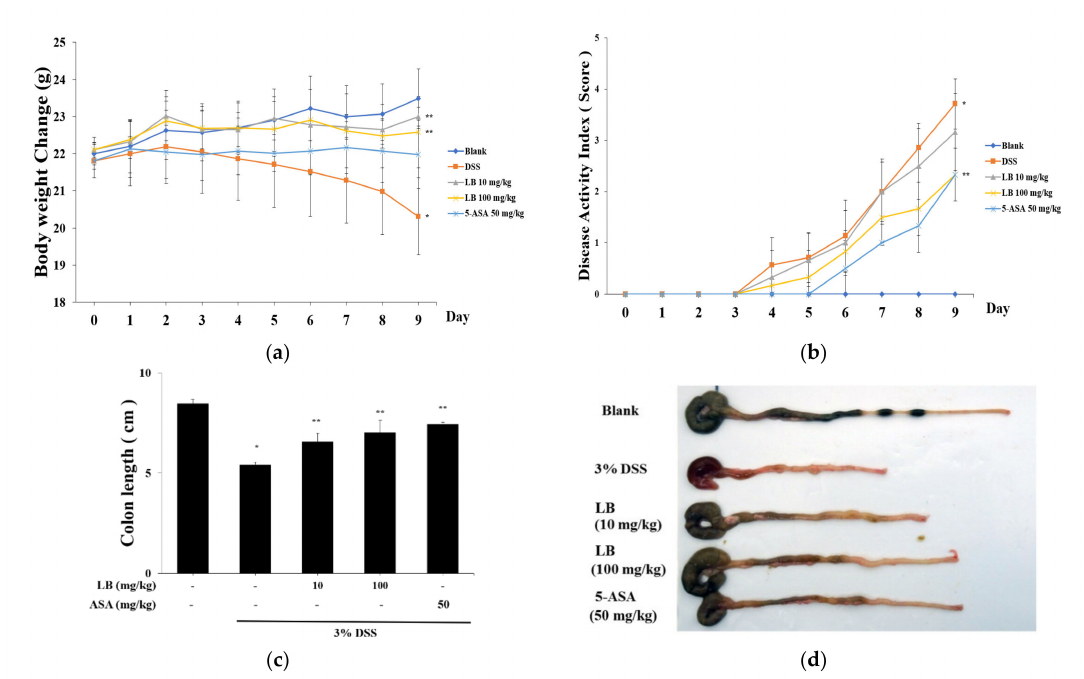
Figure 1. The effect of LB on clinical signs of UC in DSS-induced mice. The mice were administered with 3% DSS to induce UC, then LB and 5-ASA were given to treat UC clinical signs. ( a ) Body weight change; ( b ) disease activity index score; ( c ) colon length; ( d ) photograph of the colon. Values are represented as the mean ± S.D. The data were analyzed by Bonferroni’s post-hoc test. * p < 0.05 versus Blank group and ** p < 0.05 versus DSS group.